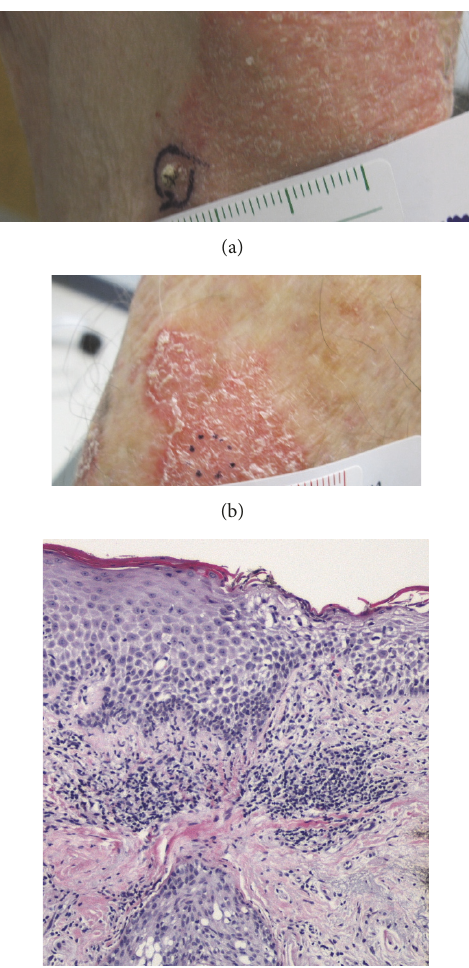
Figure 1: (a) Well-demarcated, erythematous patch with scale on the extensor surface of the right arm. (b) Dots indicate site of biopsy within lesion on the right arm. (c) Biopsy revealed spongiosis and perivascular lymphocytic infiltrate (hematoxylin and